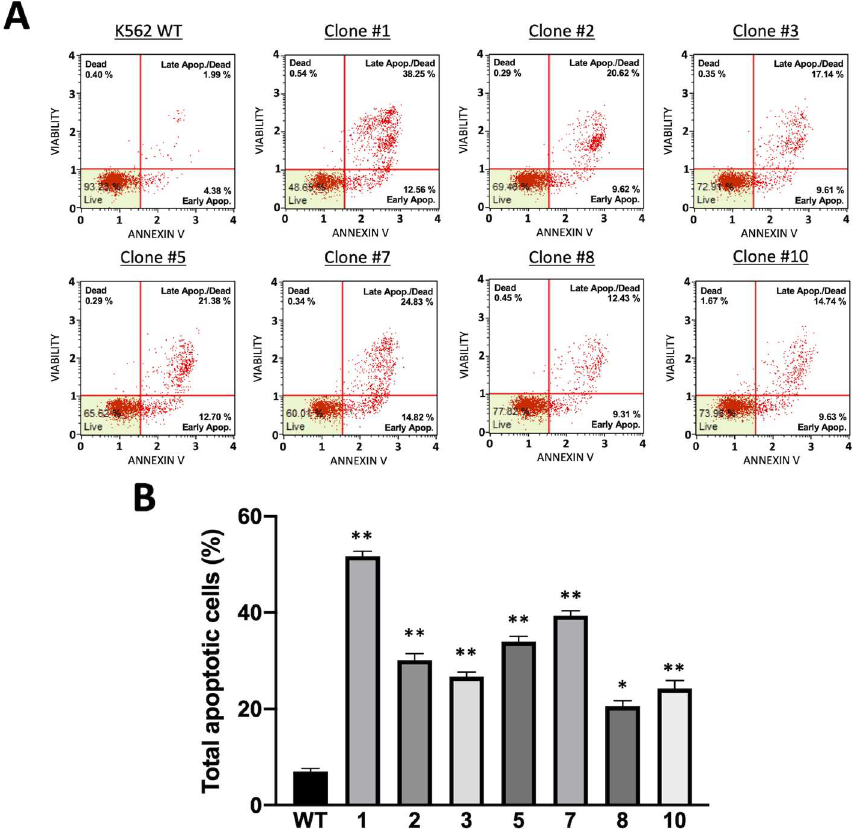
Figure 9. ( A ) Representative dot plot obtained from flow cytometric analysis of apoptosis. Each obtained clone was cultivated without Hygromycin selection antibiotics to evaluate apoptosis induced by α-globin hyper-production. ( B ) Summary of percentage increase in apoptotic cells in K562 clones hyper-expressing α-globin protein (mean ± SD; N = 3). p < 0.05 (*), p < 0.01 (**).